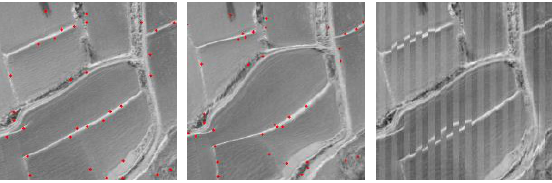
Figure 1. The original panchromatic ortho-image (left) is warped arbitrarily to generate the middle image. Then the conventional feature-based method is applied to predict the deformation. The result is shown to the right, where bars alternately display the original image and the rectified image based on the estimated